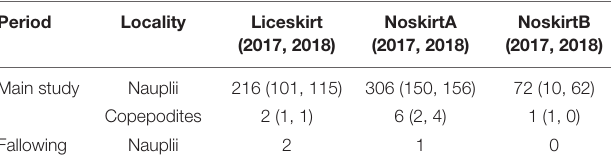
in the outside sample from the same months of the previous